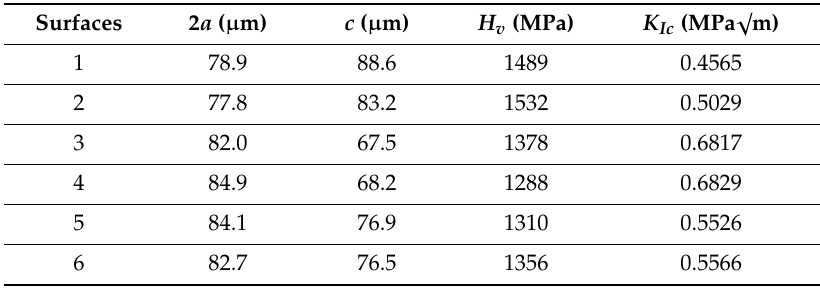
Table 2. Mechanical properties, and indentation and crack dimensions.